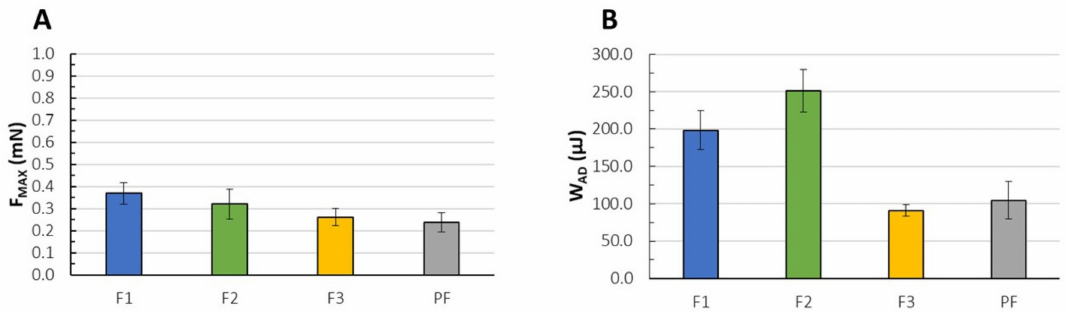
Figure 5. The maximum detachment force (F MAX ) ( A ) and the work of adhesion (W AD ) ( B ) recorded for F1–F3 and the placebo films (PF) (mean ± SD, n = 3, p <